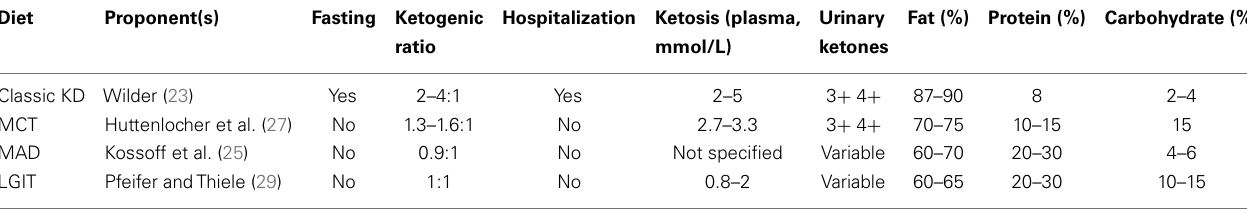
Table 1 | Ketogenic diets (KDs) used to treat pharmacoresistant epilepsy are listed